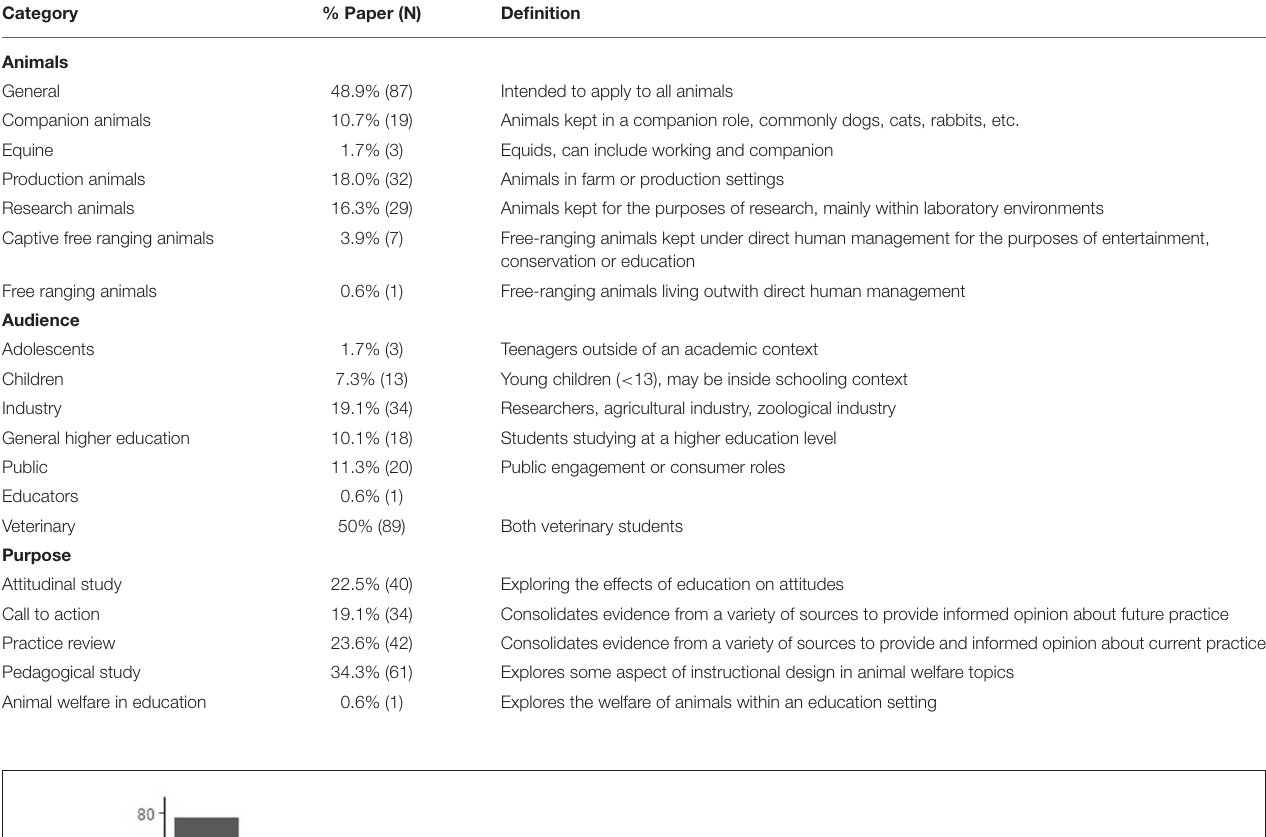
TABLE 1 | Category definitions for 178 papers regarding animal welfare education.